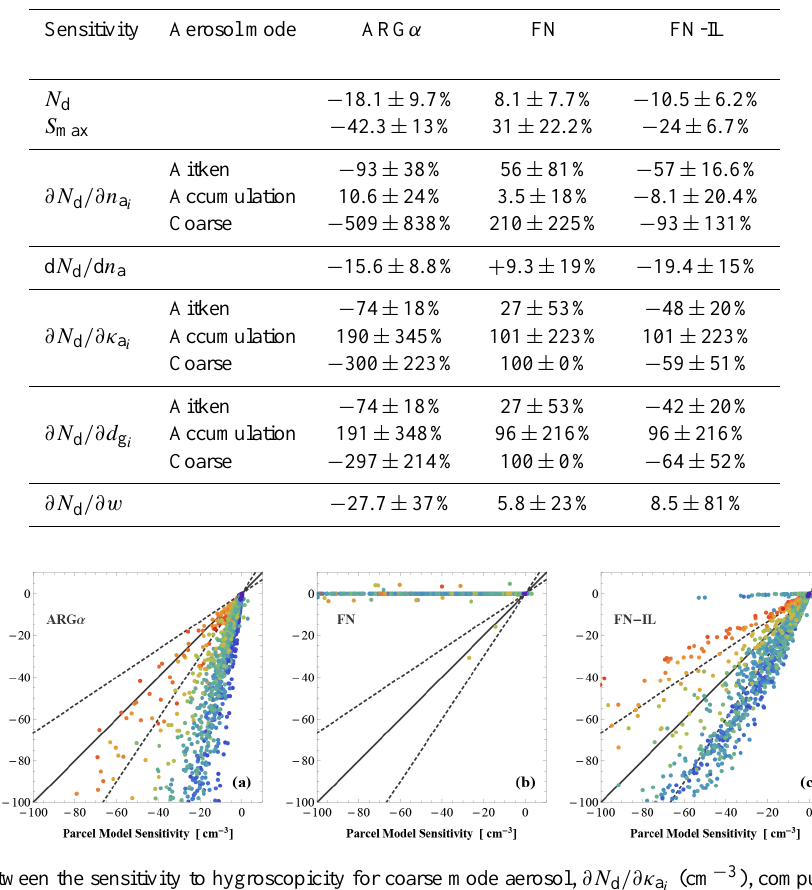
(cm − 3 ), computed with detailed parcel i